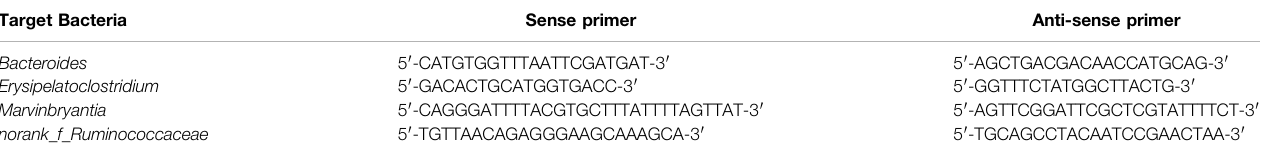
TABLE 1 | Primer sets used in this